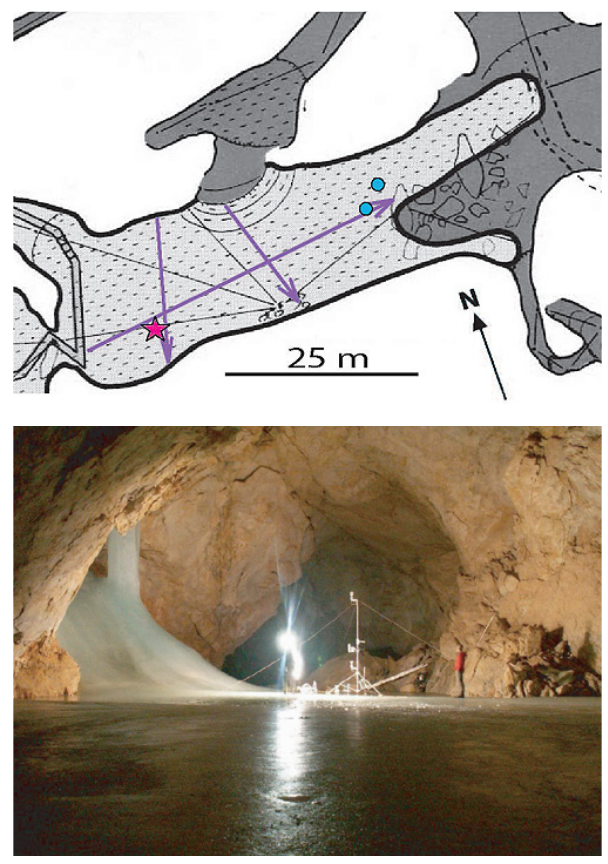
Fig. 2. Map and photo of the Eispalast. The purple arrows in- dicate the GPR profiles (Behm and Hausmann, 2007; Hausmann and Behm, 2010) the pink star marks the position of the core and the blue circles indicate the mass-balance measurements (stack in- spection and ultrasonic ice-height recording (Obleitner and Sp¨otl, 2010)). The photo shows the view from the tour walkway towards the eastern, ice-free part of the Eispalast and the meteorological sta- tion set up there between 2007 and 2009 next to the ice column.